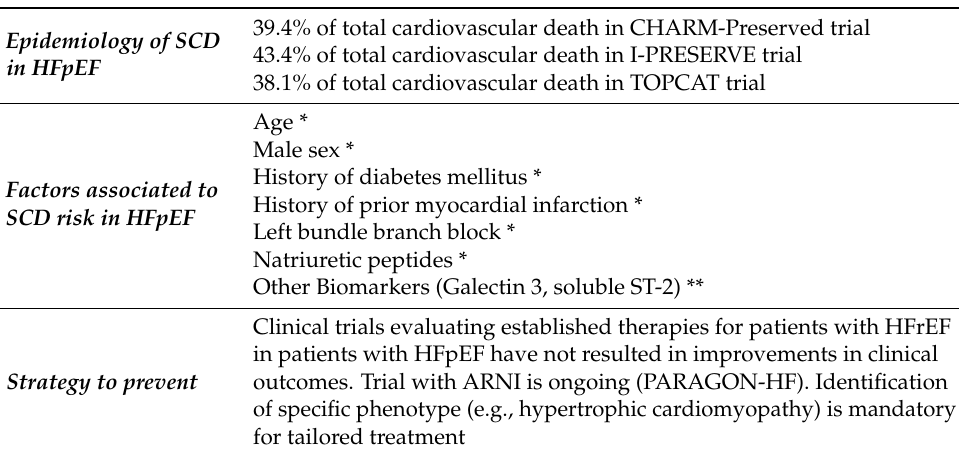
Table 3. Clinical aspect of sudden cardiac death in Heart Failure Preserve Ejection